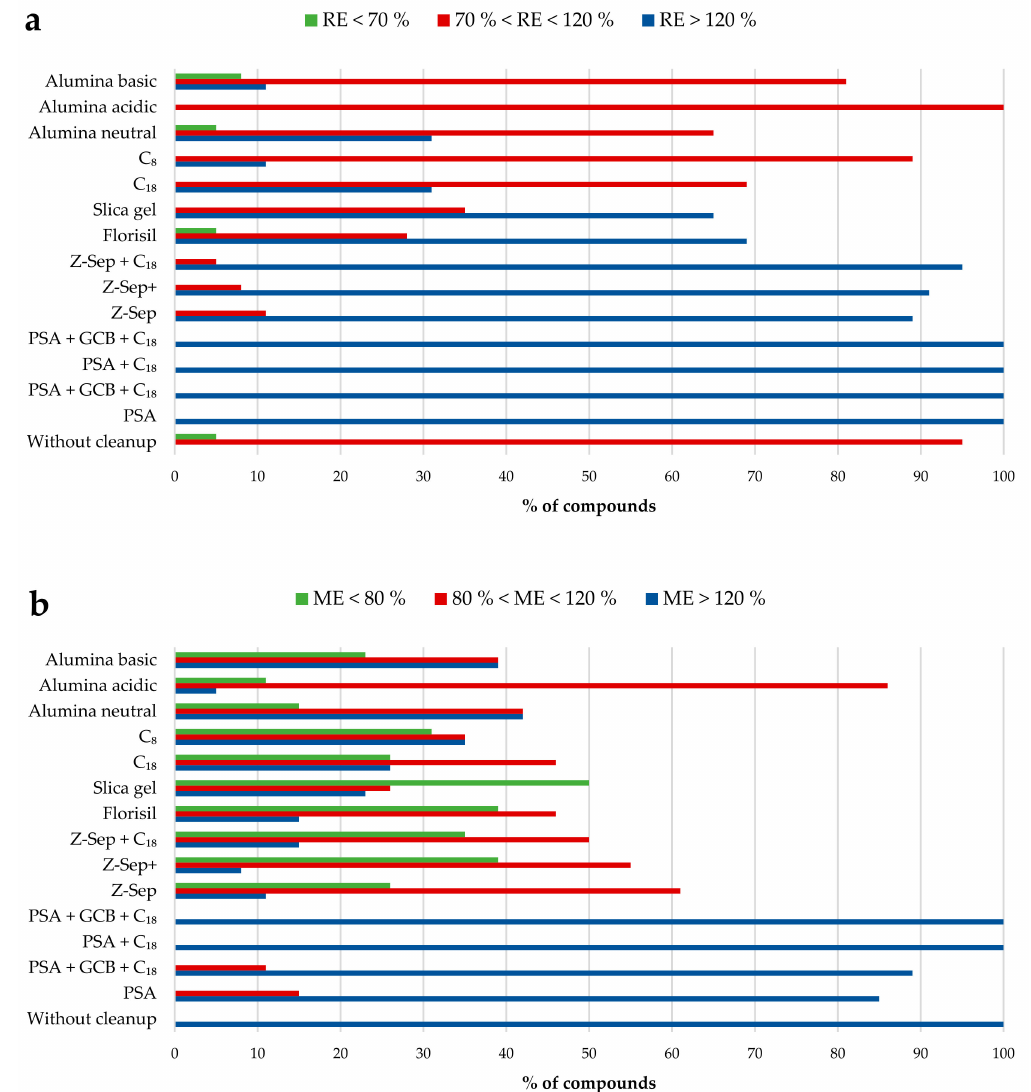
Figure 3. ( a ) Recoveries and ( b ) matrix effects of acid herbicides from various d-SPE sorbents. When matrix-effect (%) values are near to 100%, there is no matrix effect. Matrix-effect (%) values between 80% and 120% are mild. Matrix-effect (%) values below 80% or above 120% are strong. Reprinted from [30], with permission from